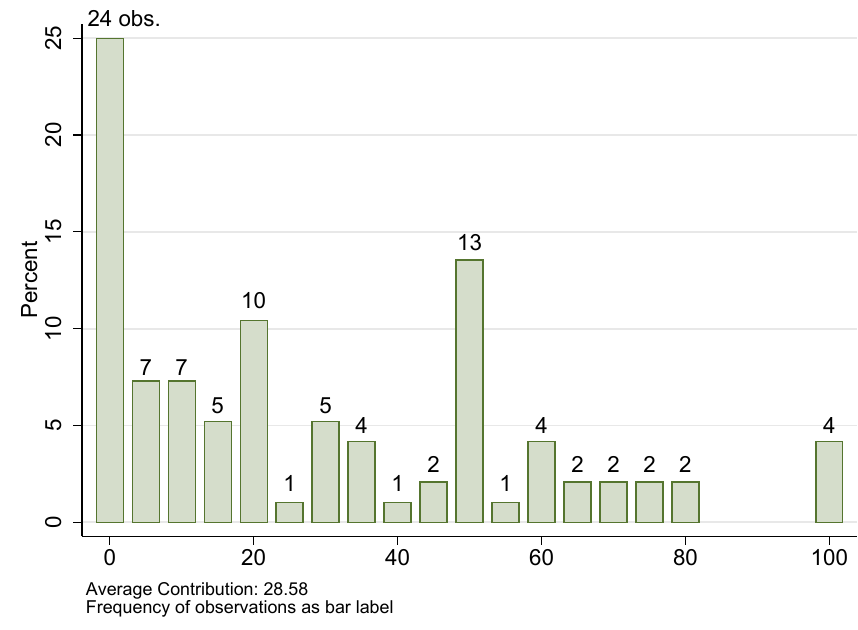
Figure 1. Contribution to the Team